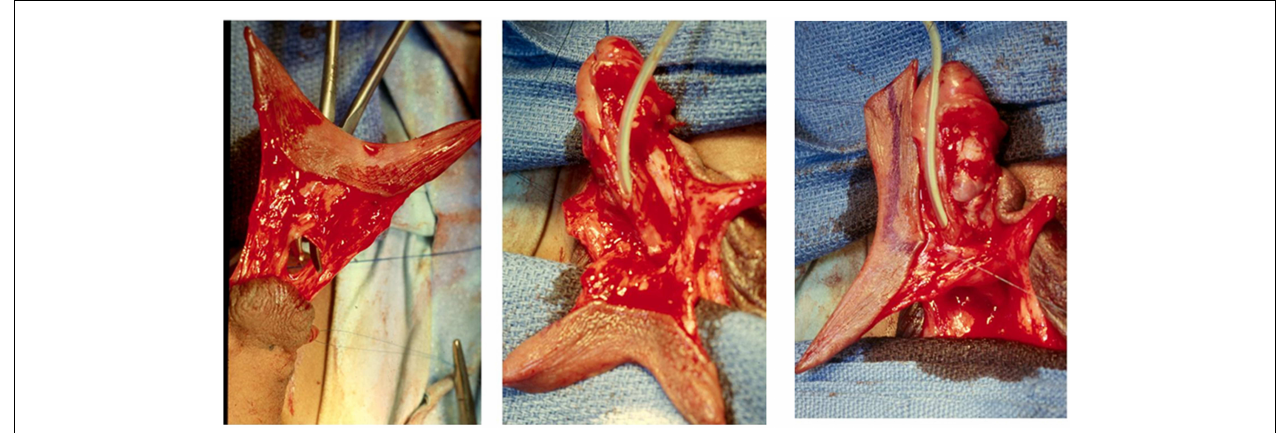
was corrected with preservation of the urethral plate and theTPF was used for a double face preputial island flap (DOPF).The area marked with blue pencil was used for the onlay and part of the remaining flap for ventral coverage.